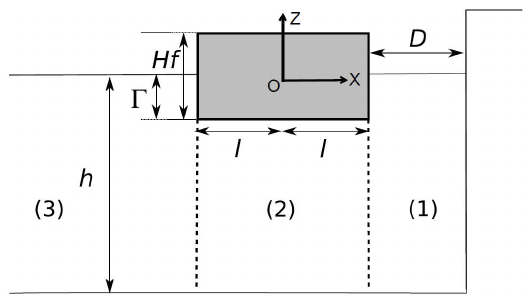
Figure 1. Floating buoy and dike